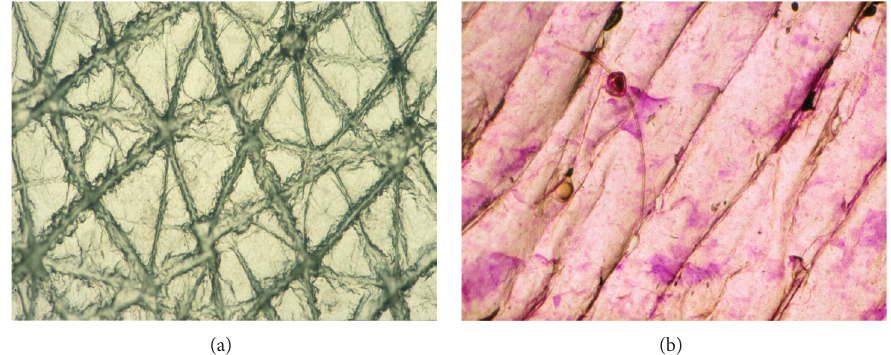
Figure 1: CSSS from the forearm. (a) Young subject showing the criss-cross pattern of shallow lines. (b) Older individual with parallel orientation of shallow lines.